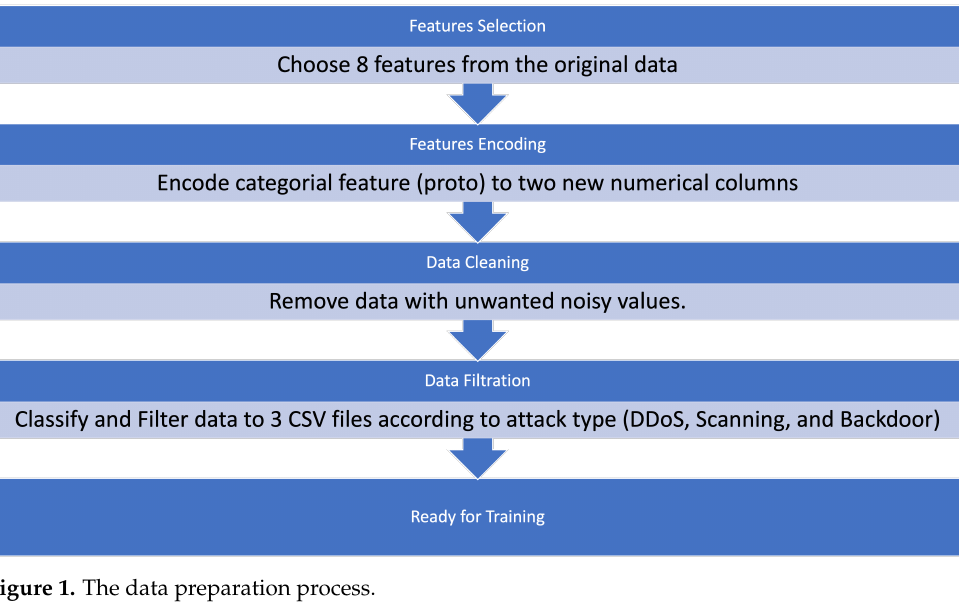
Figure 1. The data preparation